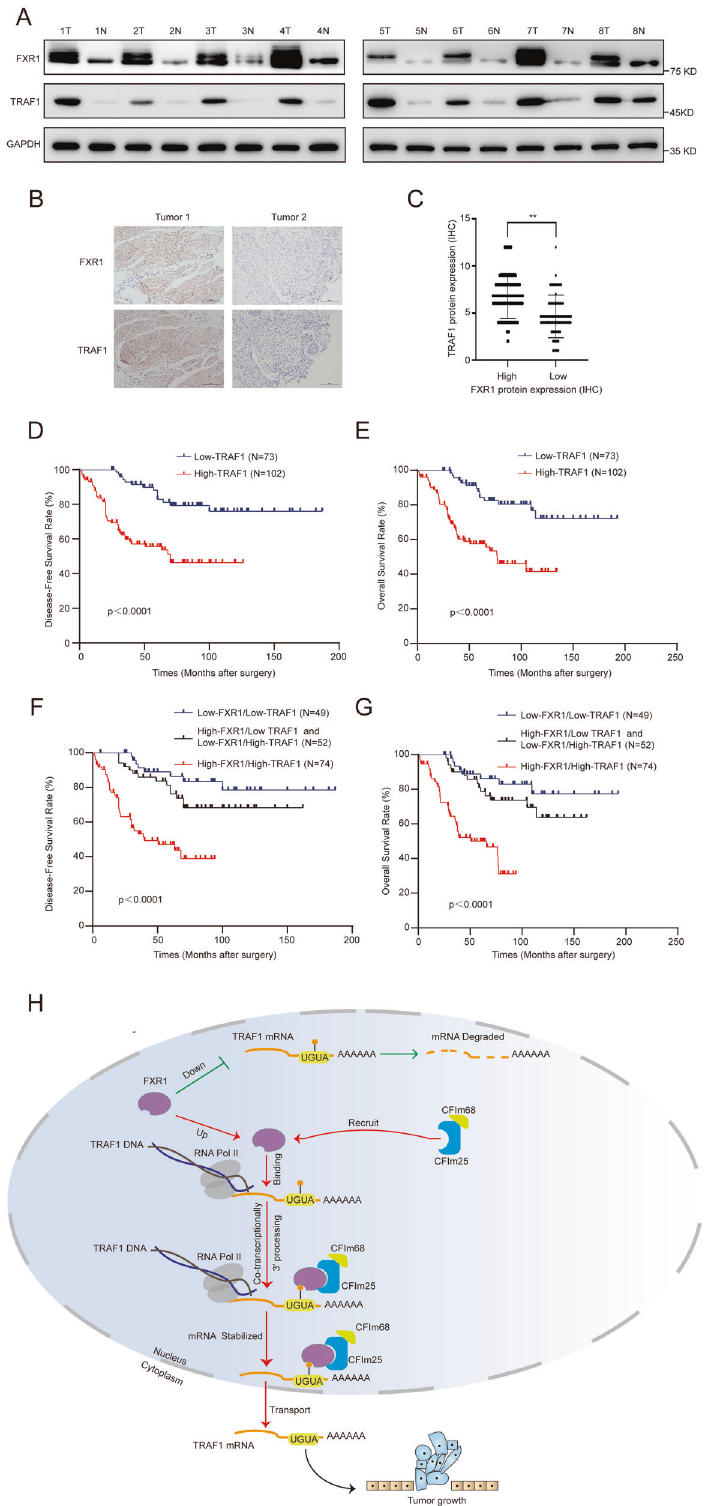
Fig. 7 High expression of both FXR1 and TRAF1 predicts the worst prognosis for patients with UCB. A Western blot showing the upregulated expression of FXR1 and TRAF1 in eight paired UCB tissues. B Representative images of IHC staining showing the correlation of FXR1 and TRAF1 expression in UCB. C IHC scores of FXR1 and TRAF1 in tumor tissues. D , E Survival analysis showing that high expression of TRAF1 predicts poor DFS and OS rates in SYSUCC UCB patients. F , G Survival analysis shows that high expression of both FXR1 and TRAF1 predicts the worst prognosis in SYSUCC UCB patients. H Working model demonstrating that FXR1 regulates the oncogenesis of UCB by regulating the 3 ′ processing of TRAF1 .